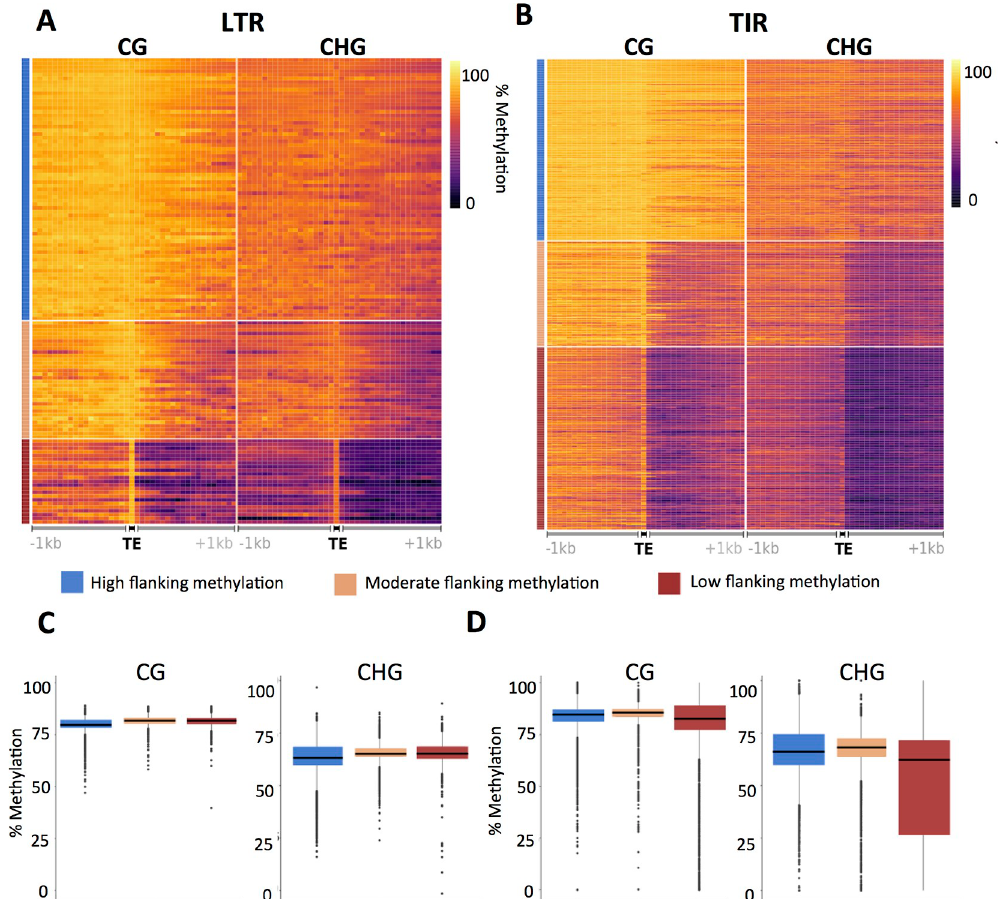
Fig 2. Variation in the profiles of CG and CHG methylation flanking TE families. (A-B) For 126 LTR families (A) and 438 TIR families (B) that include > = 20 non-nested annotated members the metaprofile of CG and CHG methylation was determined. Each element was oriented such that the 1kb flanking the TE with higher average methylation is plotted on the left. The profiles of CG and CHG methylation were used to perform k-means (n = 3) clustering and the profiles were plotted with a heat map. Three clusters were defined using k-means clusters of CG and CHG methylation profiles for each element and these clusters are classified as having high (H, blue), moderate (M, orange) and low (L, red) flanking CG and CHG methylation are indicated. (C-D) The average level of CG and CHG methylation within each LTR (C) and TIR (D) assigned to the clusters was determined and used to generate boxplots to investigate differences in methylation levels for the three